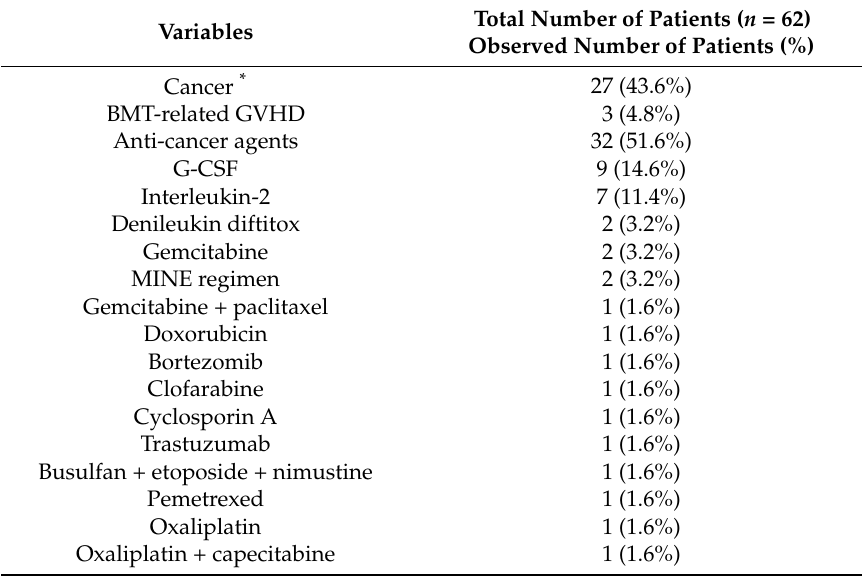
Table 2. Etiologies of cancer patients with systemic capillary leak